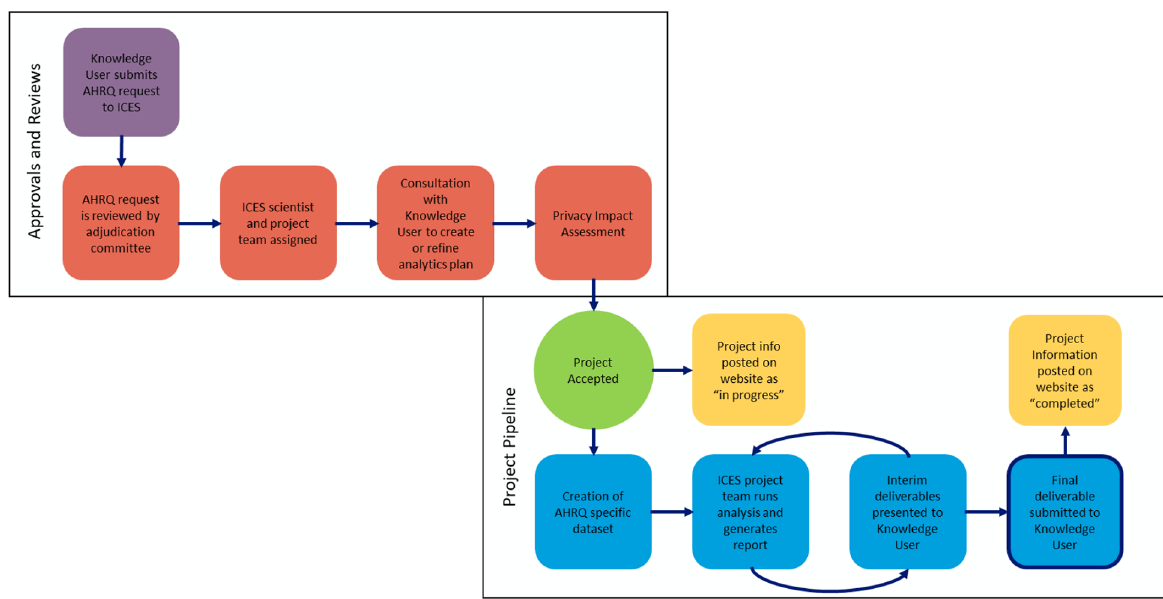
Figure 2: ICES AHRQ program process